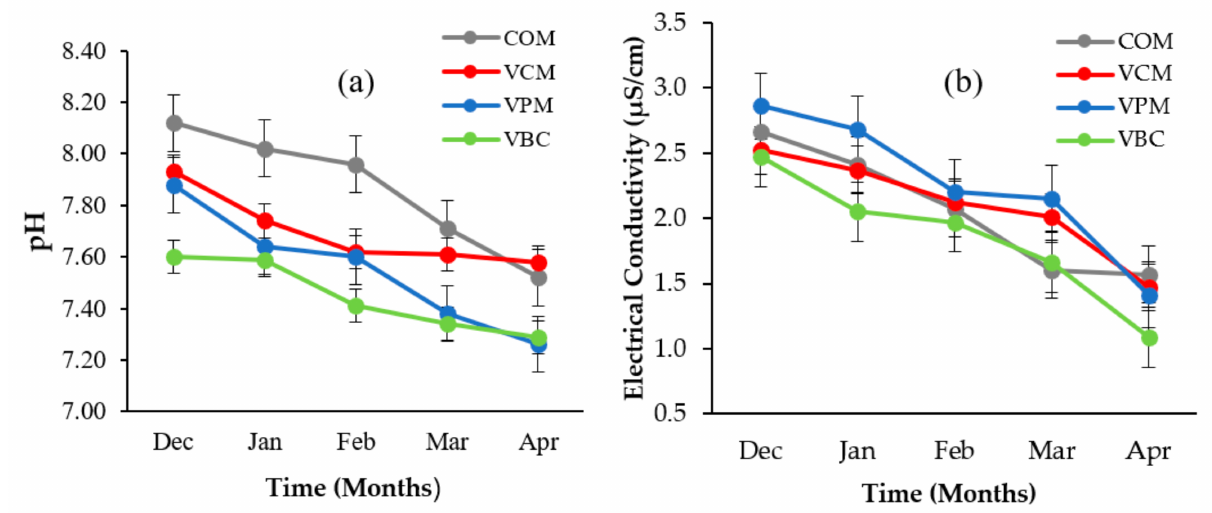
Figure 2. Temporal variations of pH ( a ) and electrical conductivity ( b ) over a period of five months for four treatments. Error bars represent standard errors ( n =